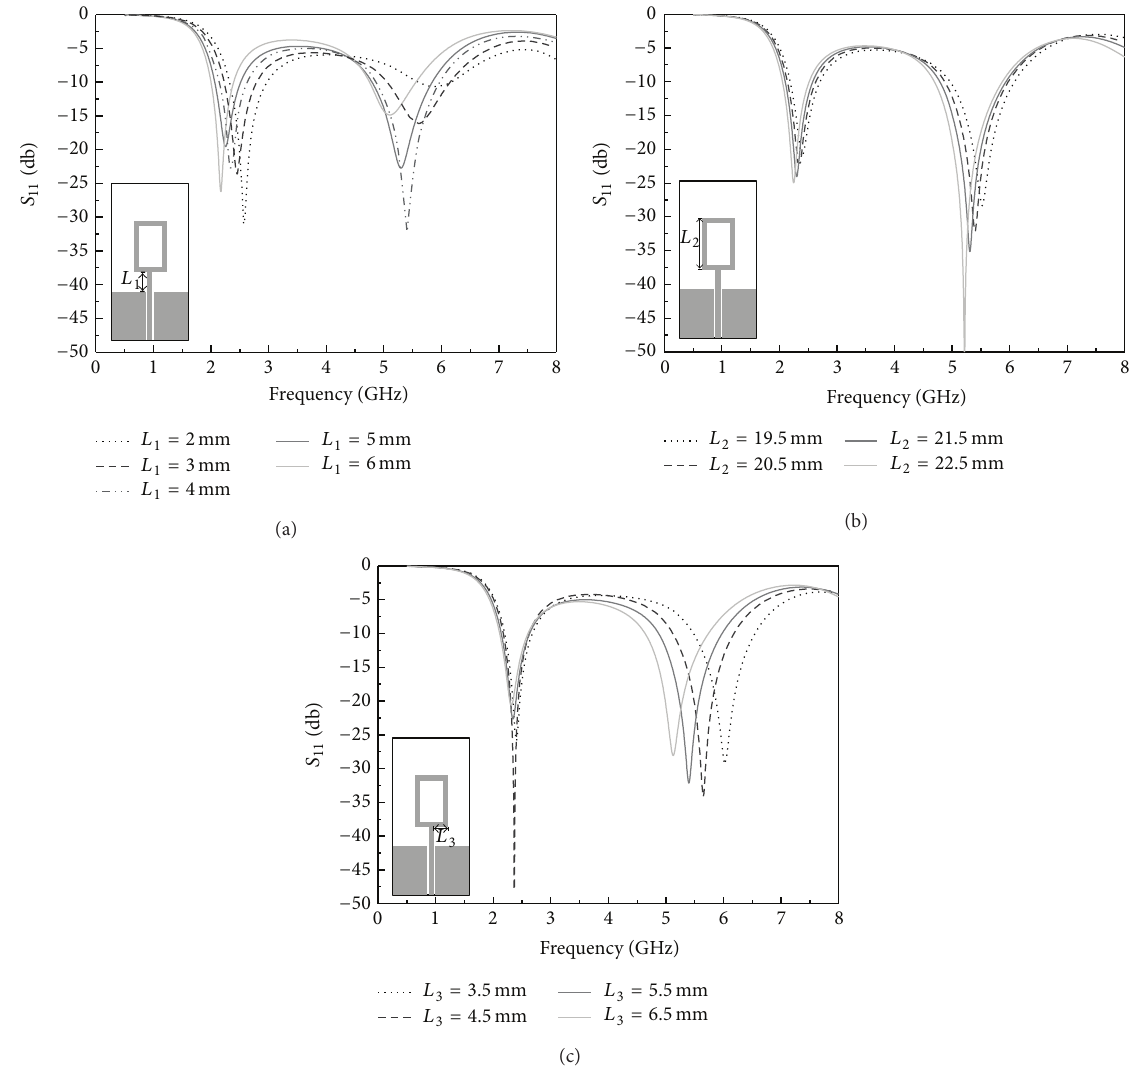
Figure 2: Simulated return losses for various values of (a) 𝐿 1 , (b) 𝐿 2 , and (c) 𝐿 3